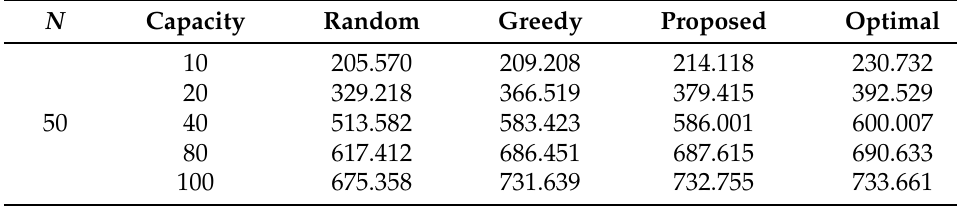
Table 12. Average profit of selected items per capacity in